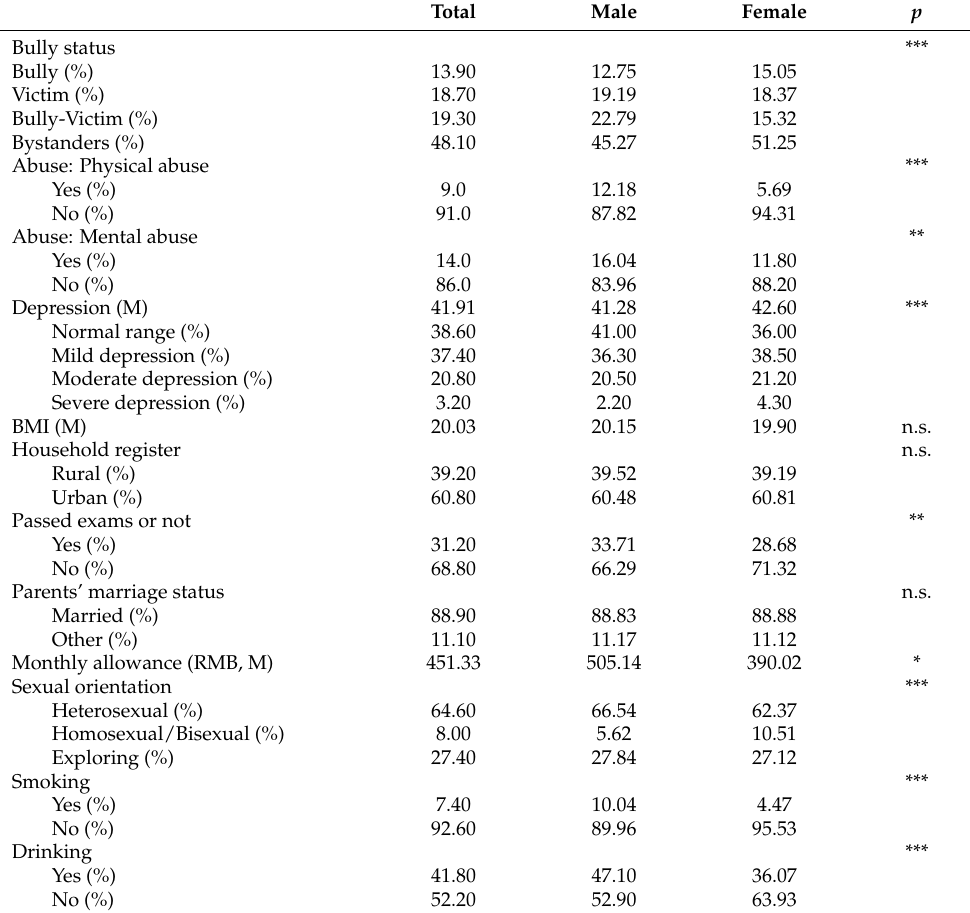
Total Male Female